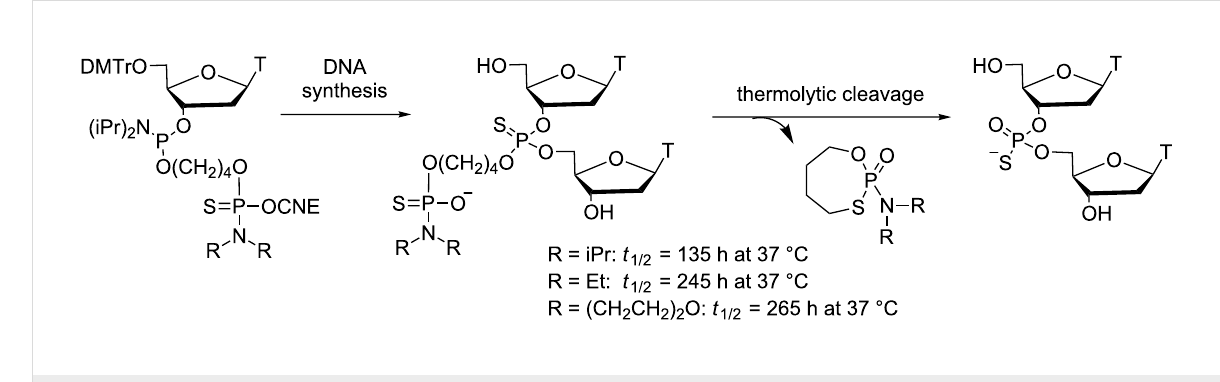
Scheme 15: Synthesis via phosphoramidite chemistry and thermolytic cleavage of alkylated (diisopropyl, diethyl, morpholino) phosphoramidothioyl- butyl internucleoside linkages